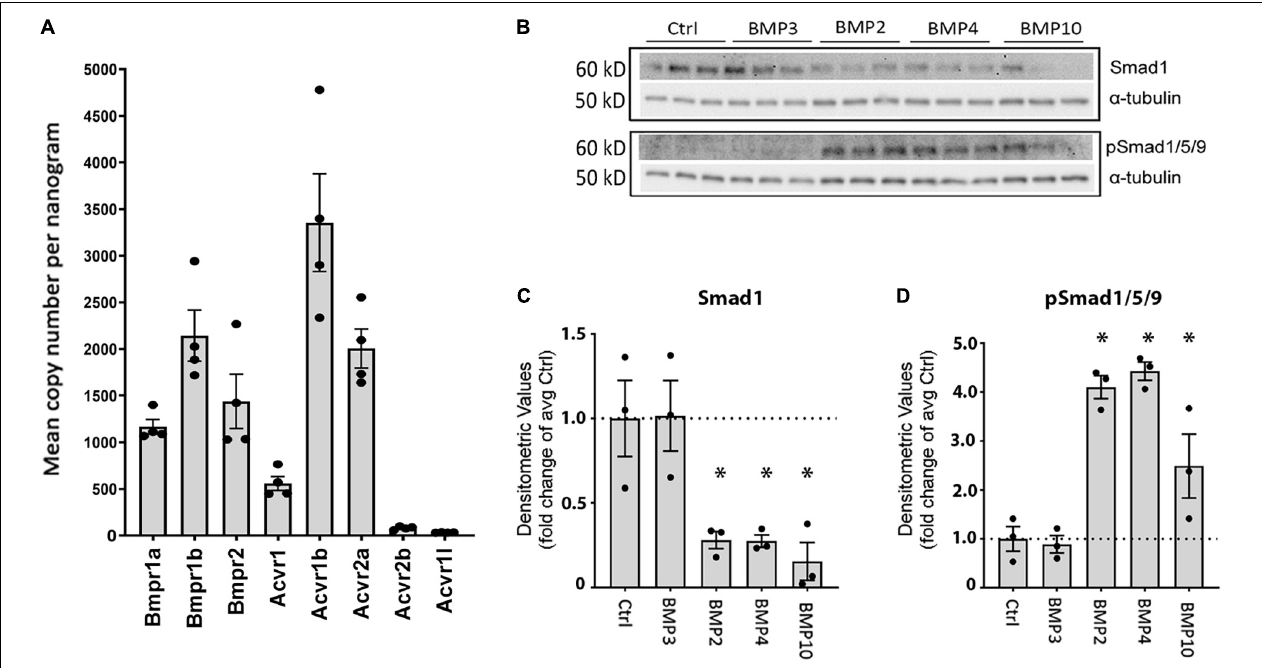
FIGURE 4 | Matured primary astrocytes express BMP receptors and reveal activation of Smad1/5/9 upon treatment with canonical BMPs. (A) RT-qPCR confirms that astrocytes express BMP receptor transcripts. BMP receptor transcripts Bmpr1a , Bmpr1b , Bmpr2 , Acvr1 , Acvr1b, and Acvr2a are robustly expressed, while Acvr1 exhibits low expression and Acvr1l is not expressed. Values are presented as mean copy numbers per nanogram total RNA input into the cDNA reaction. Dots: individual sample values; Error bars = SEM; n = 4. (B–D) Immunoblots and quantification using antibodies to Smad1 and phosphorylated Smad1/5/9 (pSmad1/5/9) on protein lysates from primary astrocytes after 3 days of BMP treatment. α -tubulin was used as a loading control. ∗ Sig ANOVA LSD post-hoc test; Dots: individual sample values; Error bars = SEM; P < 0.05; n = 3. (C) Smad1 is expressed in all samples and significantly lower in cells treated with BMP2, –4, and –10. (D) pSmad1/5/9 phosphorylation is induced and significantly increased only in samples treated with canonical BMPs –2, –4, and